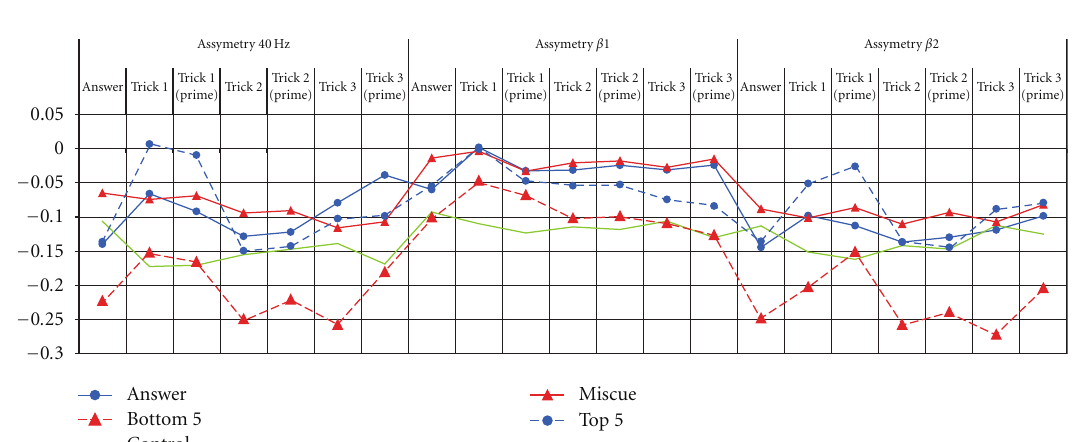
Figure 7: Asymmetry results for Beta and the 40Hz